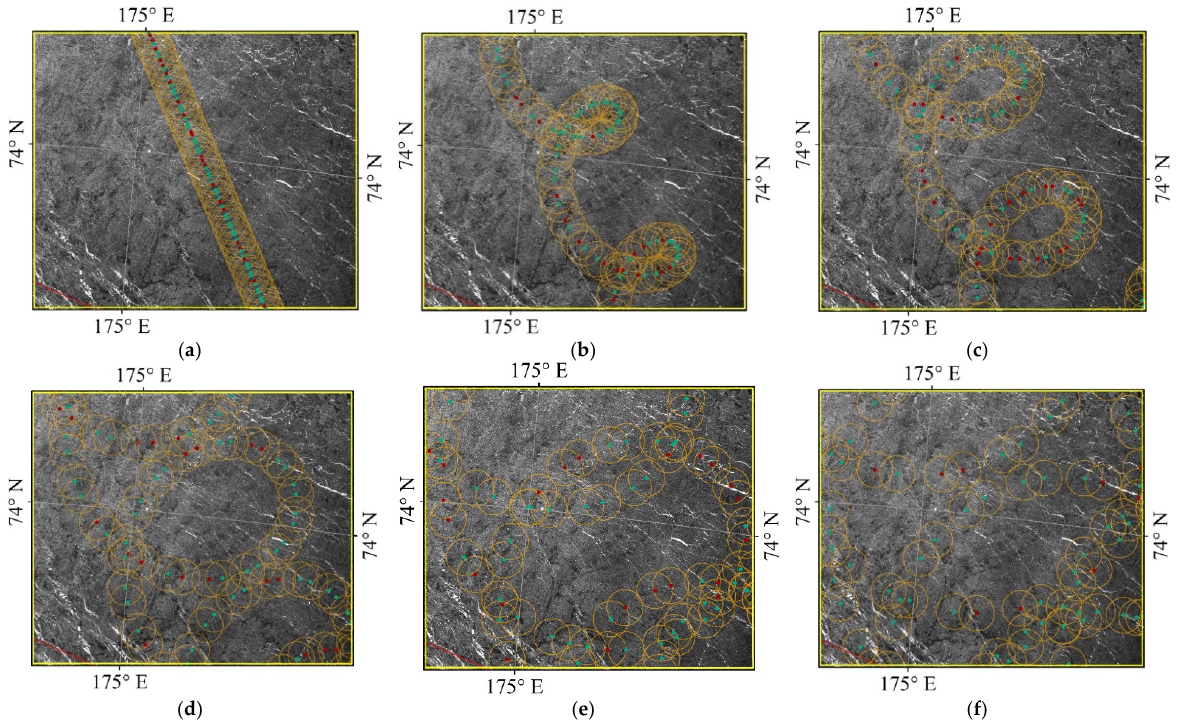
Figure 16. Classification results in the uniform area at six incidence angles. Each orange circle represents the coverage of one footprint. ( a ) 0°; ( b ) 2°; ( c ) 4°; ( d ) 6°; ( e ) 8°; ( f ) 10°.